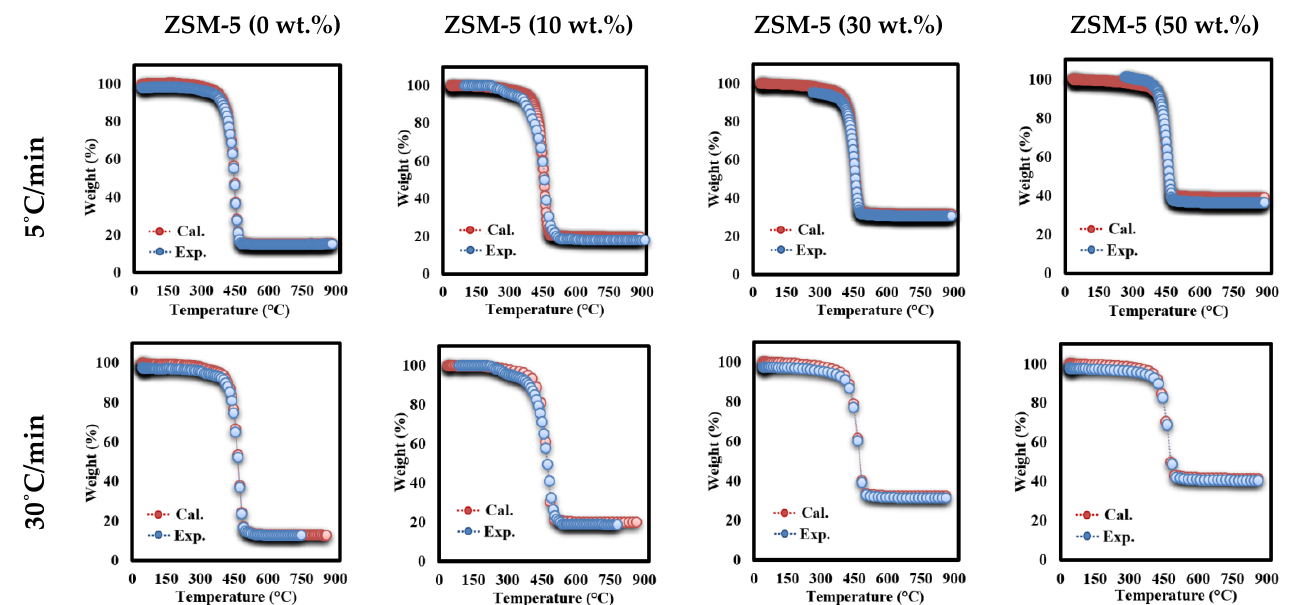
Figure 7. Fitting TGA experimental and calculated data for MFPW and ZSM-5 (30%)/MFPW samples at 5 and 30 ◦ C/min.